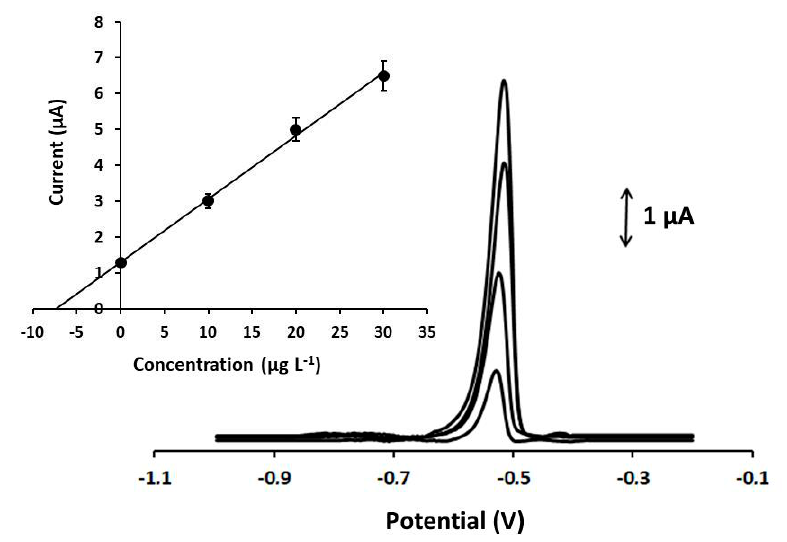
Figure 6. DP voltammograms for the determination of Pb(II) in spiked fish feed sample with 7.5 µg L − 1 of Pb(II) at the Ca-MOF/GPE. From below: spiked sample and three standard additions of 10 µg L − 1 of Pb. (Inset) Standard additions curve. Supporting electrolyte: 0.1 mol L − 1 acetate buffer (pH 4.5); preconcentration potential: − 1.2 V; preconcentration time: 360 s; pulse 40 mV for 10 ms; scan rate: 10 mV s − 1